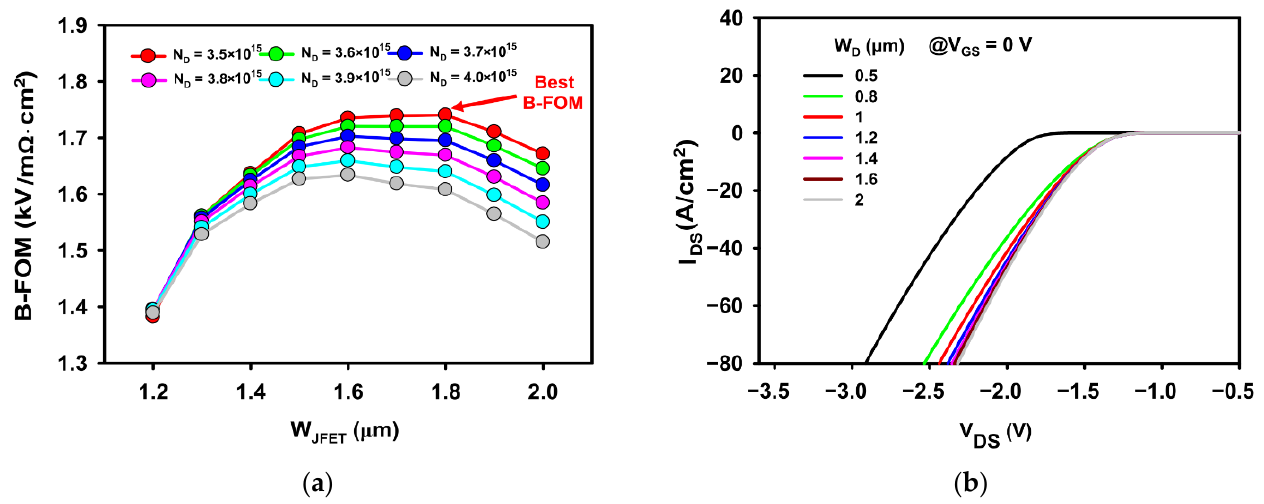
Figure 2. Comparison of the ( a ) B – FOM characteristics for WJFET and N D variation of CIMCD – MOSFET ( b ) third-quadrant characteristics for different WD of CIMCD – MOSFET.